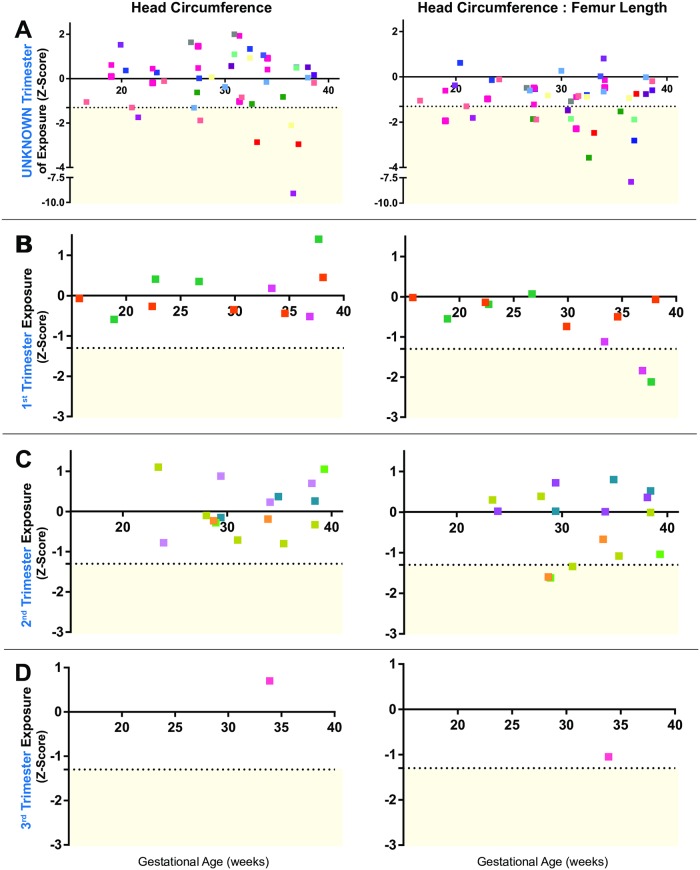
Head circumference and head circumference: Femur length ratio by trimester of ZIKV exposure.Z-scores for fetal head circumference (HC) and the HC to femur length (HC: FL) body ratio. The distribution of HC: FL is negatively skewed compared to HC measurements, indicating disproportionate growth with a smaller fetal head relative to the femur length. Each color represents data from a single ultrasound for an individual subject with colors kept consistent for each individual over time. The horizontal dotted line indicates a Z-score of -1.3, which corresponds to the 10th centile. To simplify presentation of the data, data was shown separated by the best estimate for trimester of ZIKV exposure (A: unknown trimester, B: first trimester, C: second trimester, D: third trimester). Only the latest ultrasound per trimester for each subject was shown to allow discrimination between data points.